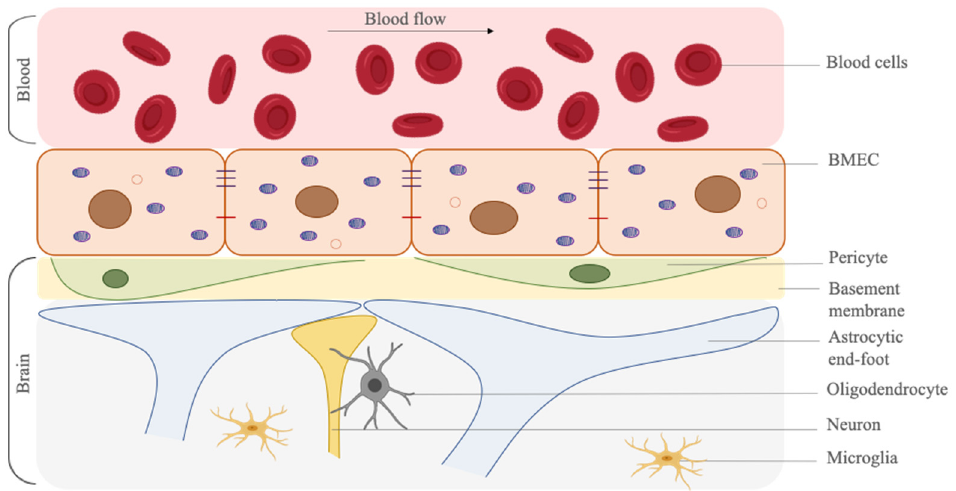
Figure 2. Schematic representation of the blood–brain barrier and the supportive cell types on the barrier function. BMECs form the lining of the brain microvasculature and they interact with multiple cells. Brain microvascular pericytes are embedded in the basal membrane and astrocytic end-feet surround brain micro vessels. Neurons, oligodendrocytes and microglia are also found in perivascular space. Created with BioRender.com (accessed on 21, May,2021).